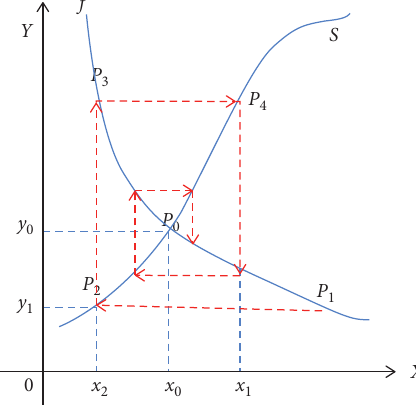
Figure 8: Convergent cobweb